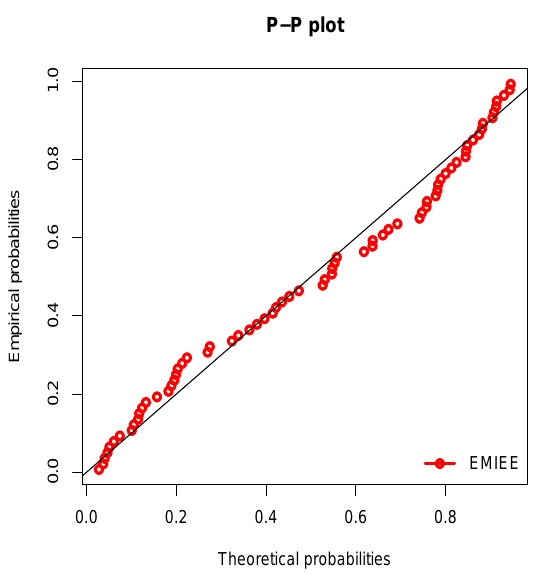
Figure 6. Probability-probability (P-P) plot of the EMIEE model for the COVID-19 dataset.